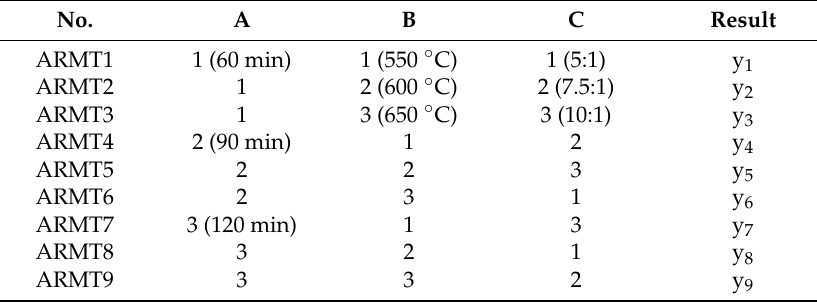
Table 5. Orthogonal experimental layout of ARMT samples.